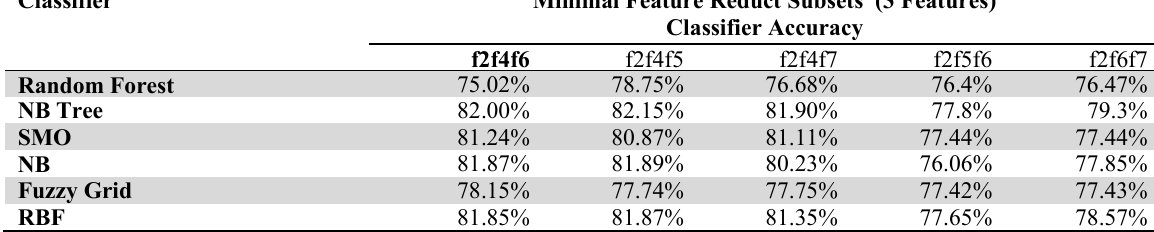
Minimal reduct subset